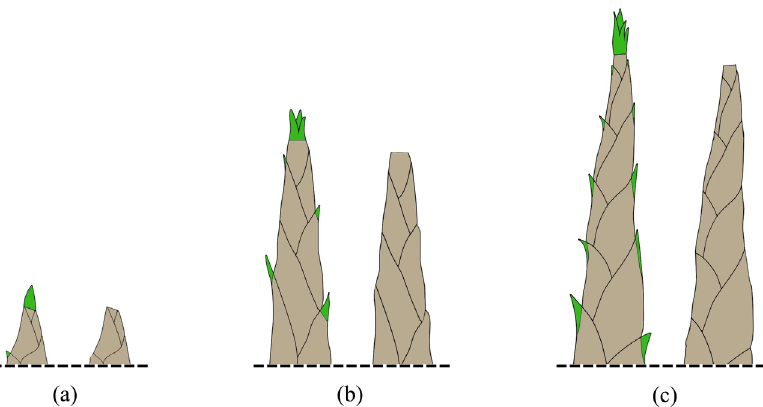
Figure 1. Schematic diagram of sheath blades removal: ( a ) treatment of sheath blade removal; ( b ) sheath blade removal after 2 d; and ( c ) sheath blade removal after 4 d. Pictures ( a – c ) show naturally growing bamboo shoots on the left and sheath blades removed bamboo shoots on the right.